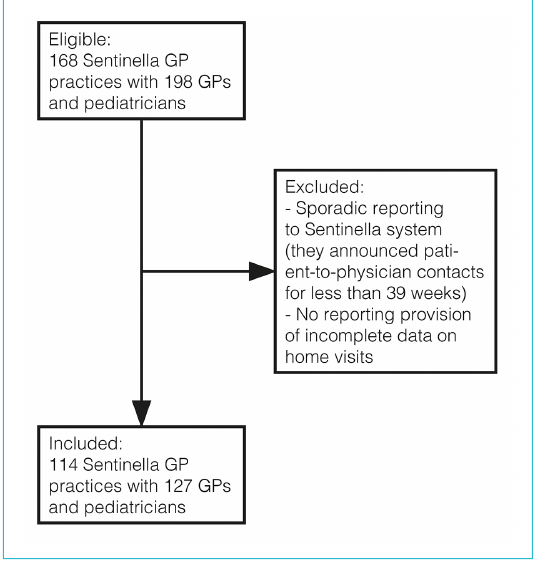
Figure 1: Flow chart of GPs invited to